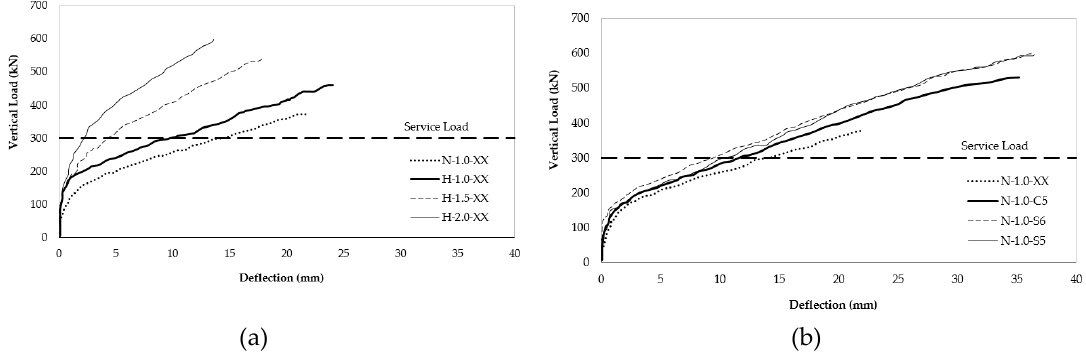
Figure 20. ( a ) Load–deflection relationship for the high-strength (80 to 87 MPa) concrete, ( b ) load– deflection relationship for normal-strength (43 MPa) concrete [41].